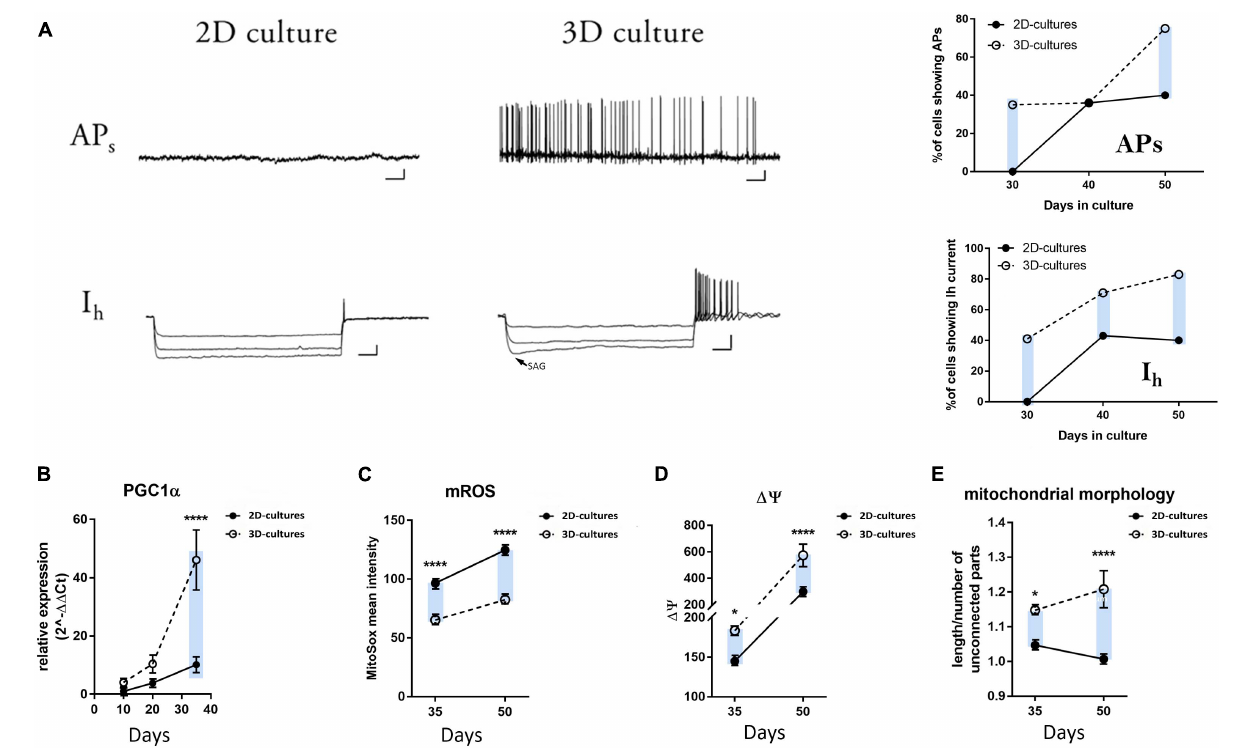
FIGURE 4 | Electrophysiological and metabolic analyses of mDA neuron maturation in the 2D and 3D cultures. (A) Representative traces of whole-cell patch clamp recordings of hiPSC-derived neurons in 2D and 3D cultures at day 30. The arrow for the hyperpolarization-activated cation current (Ih) in the 3D cultures indicates the voltage-sag response upon hyperpolarizing current injections characteristic of the HCN channel activation. Scale bars APs: 10 mV/4 sec; Ih: 20 mV/200 ms. No spontaneous or evoked APs and no Ih could be recorded for the neurons cultured in 2D ( n = 0/14 neurons). Plots on the right display the percentage of cells showing spontaneous APs and the presence of Ih at days 30, 40, and 50 during neuronal differentiation. (B) qRT-PCR analysis of PGC1- α at days 10, 20, and 35 of differentiation. (C) mROS production, (D) mitochondrial membrane potential, and (E) mitochondrial morphology in the differentiating neurons at days 35 and 50. The blue bars are illustrating an ameliorated phenotype of 3D cultures compared to the 2D